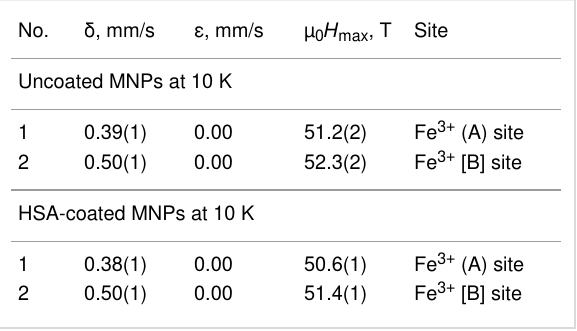
Table 1: Hyperfine parameters for two magnetic sextets calculated from the Mössbauer spectra at 10 K. H hf is the magnetic hyperfine field at iron nuclei, H max is the value at the maximum of the field in the dis- tribution function P ( H hf ) shown in Figure 7, ε is the quadrupole shift, and δ is the isomer shift. The calculation was based on the A- and B-site occupation by Fe 3+ at a ratio of 1:1.67, which is characteristic of maghemite.